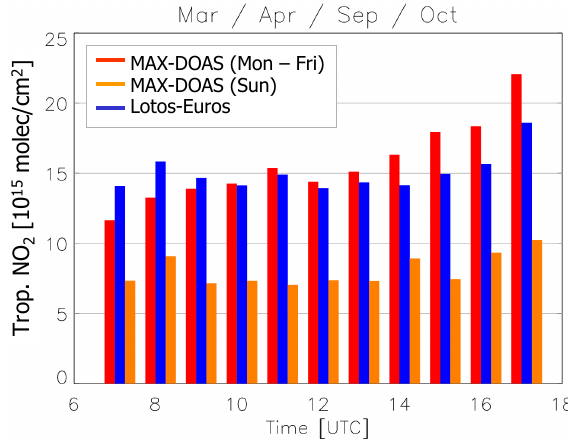
Figure 9. Average tropospheric NO 2 column for each day of the week. Figure 10. Average tropospheric NO 2 column for each hour of